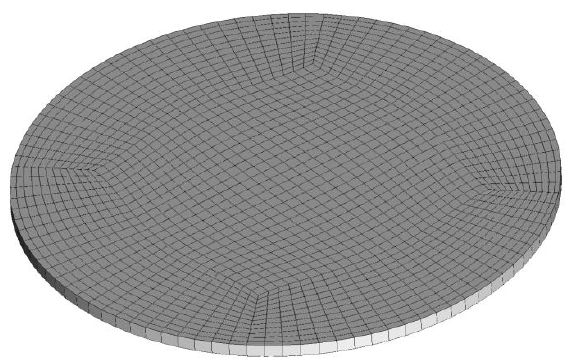
Figure 6. Meshindependence test for a porous media model of a nine-layer reactor with 3-mm spheres (the chosen mesh contains 175 10 3 cells).